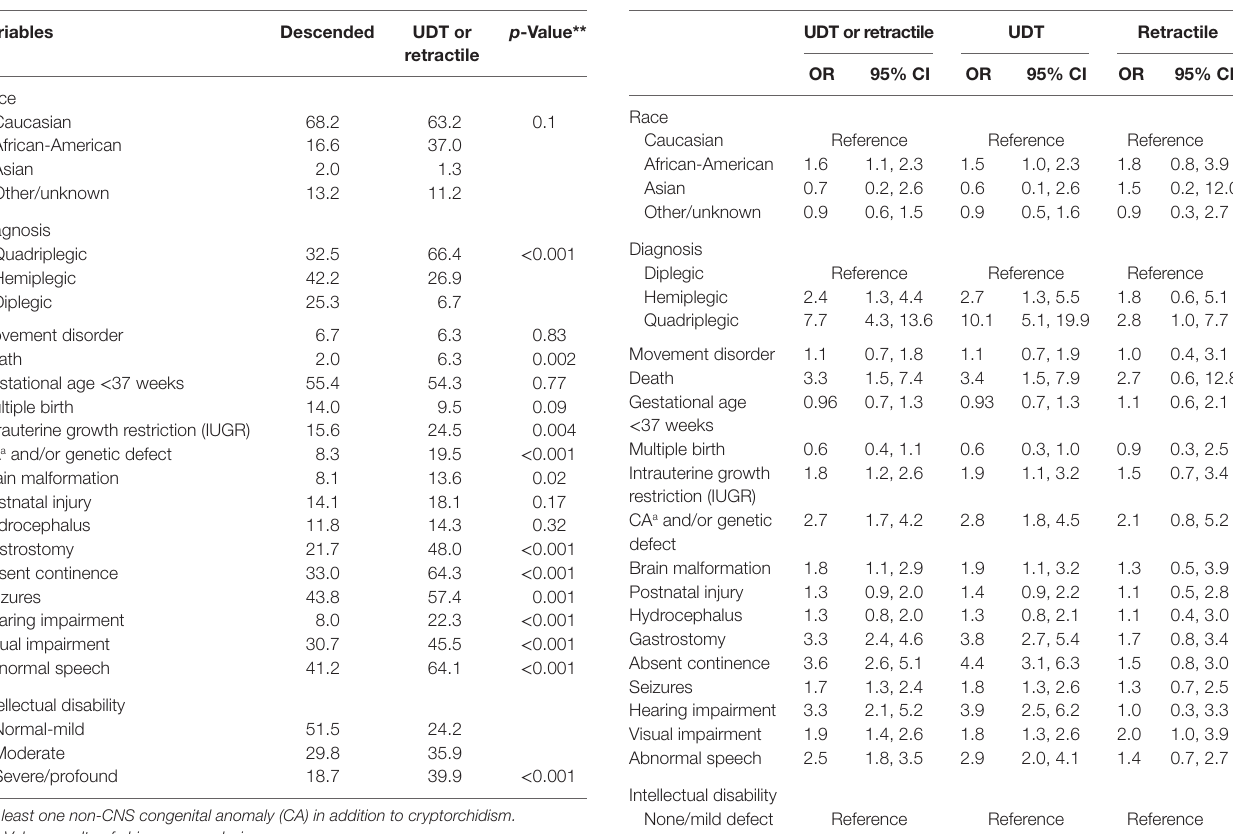
TaBle 2 | Frequencies (%) of subtypes and comorbidities in boys with cerebral palsy and descended or retractile vs. undescended testes. Variables Descended